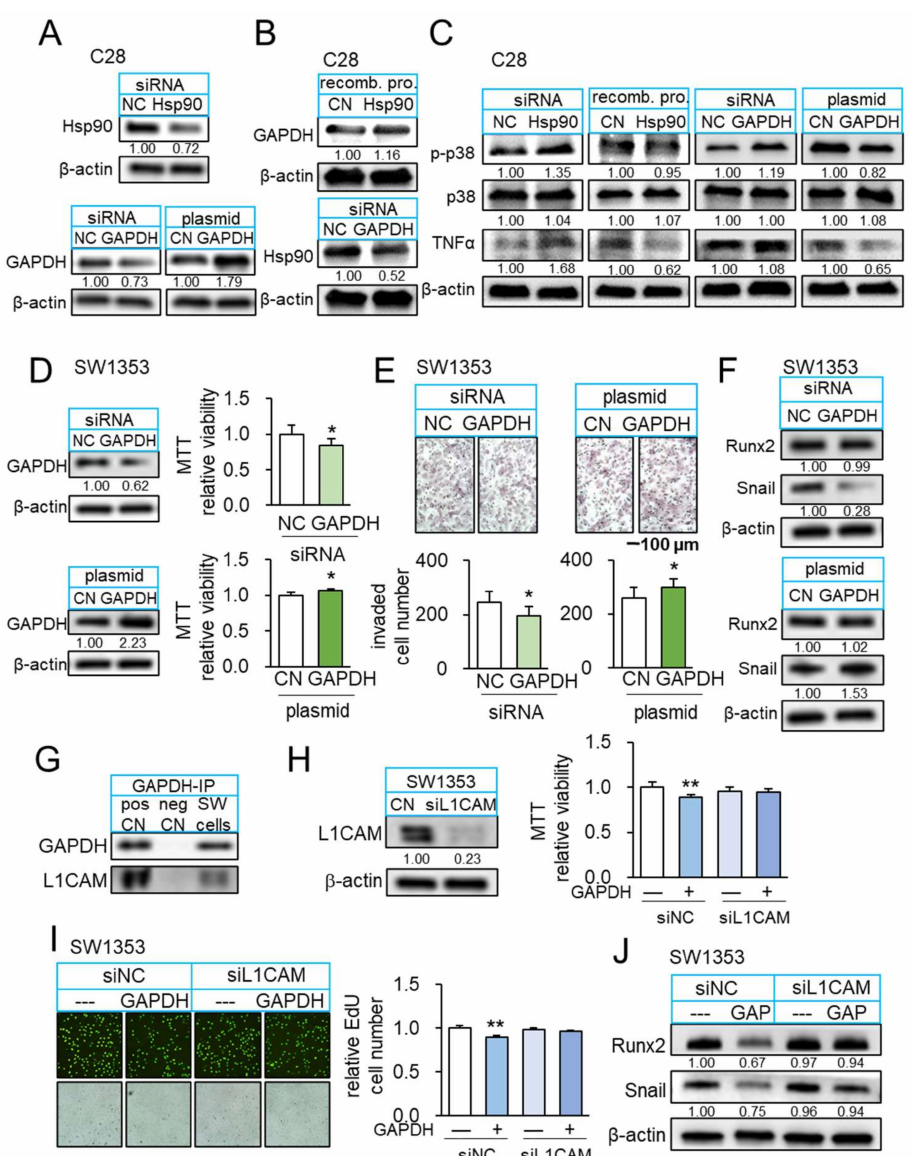
Figure 6. Interaction of GAPDH and L1CAM. The single and double asterisks indicate p < 0.05 and 0.01, respectively. ( A ) Expression levels of Hsp90ab1 and GAPDH after their silencing or overexpression in C28/I2 chondrocytes. ( B ) Upregulation of GAPDH in response to recombinant Hsp90ab1proteins, and downregulation of Hsp90ab1 by silencing GAPDH in C28/I2 chondrocytes. ( C ) Elevation of p-p38 and TNF α by silencing Hsp90ab1 in C28/I2 chondrocytes, while their reduction in response to recombinant Hsp90ab1 protein. Elevation of p-p38 and TNF α by silencing GAPDH in C28/I2 chondrocytes, while their reduction in GAPDH-overexpressing C28/I2 chondrocytes. ( D , E ) Reduction in MTT-based viability and transwell invasion by silencing GAPDH in SW1353 cells and the opposite effect in GAPDH overexpressed SW1353 cells ( n = 6). ( F ) Downregulation of Snail by silencing GAPDH in SW1353 cells and elevation of Snail in GAPDH overexpressed SW1353 cells. ( G ) Co-immunoprecipitated L1CAM with GAPDH. ( H , I ) Suppression of GAPDH-mediated inhibition of MTT-based viability and EdU-based proliferation of SW1353 cells by RNA silencing of L1CAM ( n = 6). ( J ) Downregulation of Runx2 and Snail in response to recombinant GAPDH in SW1353 cells, and its suppression by silencing L1CAM. Full Western blot images are available in Figure